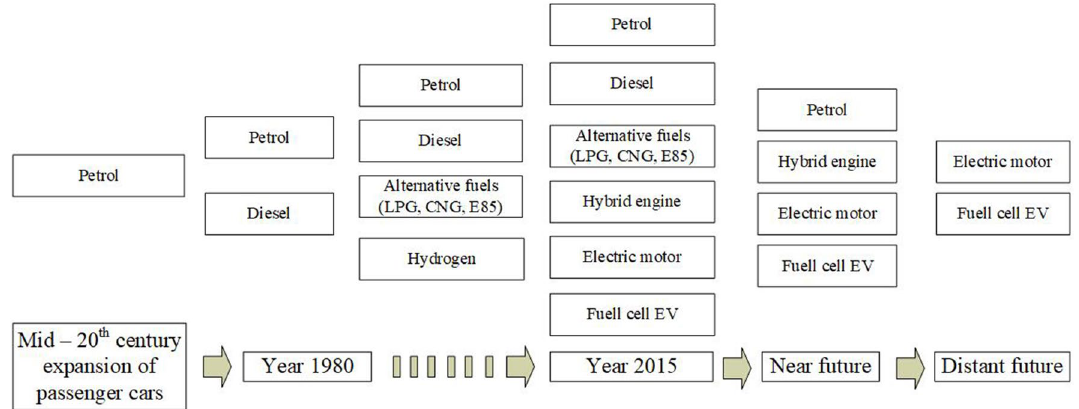
Figure 3. Representation of the development of propulsion in passenger cars and expected development.